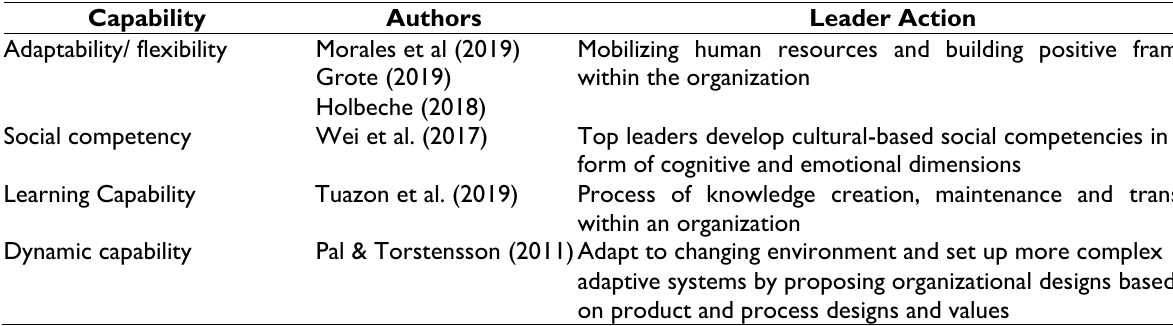
Table 9: Capabilities for Organizational